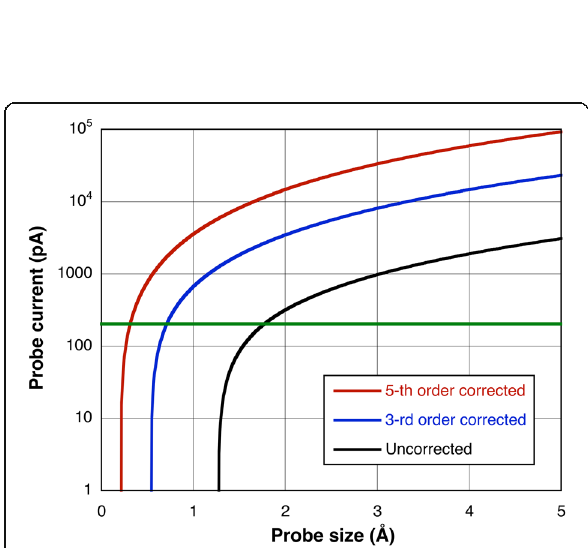
Fig. 9 Variation of probe current with probe size for uncorrected, third- and fifth-order-corrected 300 kV microscopes assuming a source brightness of 3 × 10 9 A sr − 1 cm − 2 . Below the green line, the probe is predominantly coherent whereas above it is predominantly incoherent. Adapted from Pennycook 2016, with permission from Springer Nature. Copyright 2016